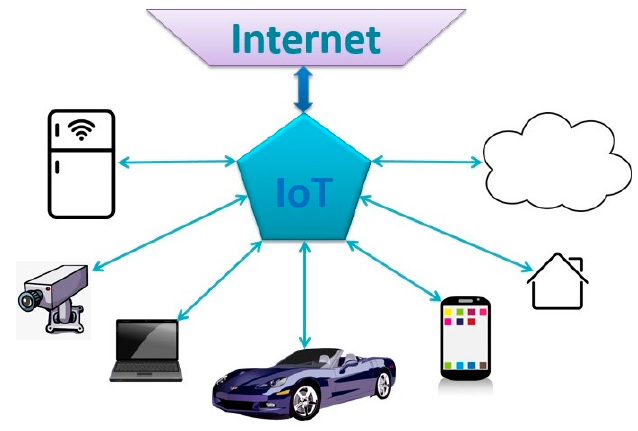
Figure 2. Internet of Things.